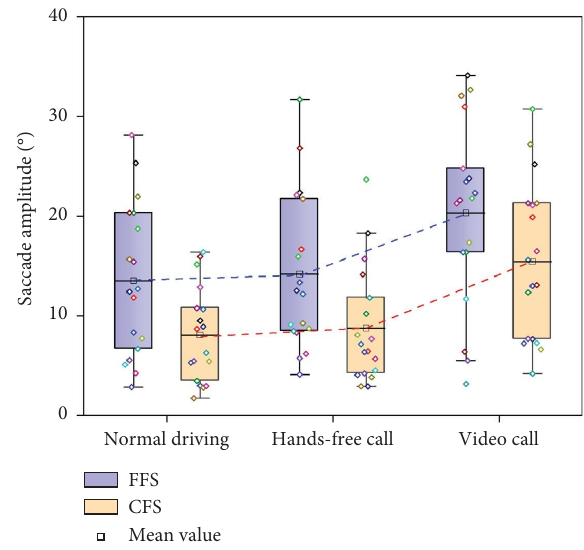
Figure 5: Comparison of drivers’ saccade amplitude for each driving state in diferent trafc